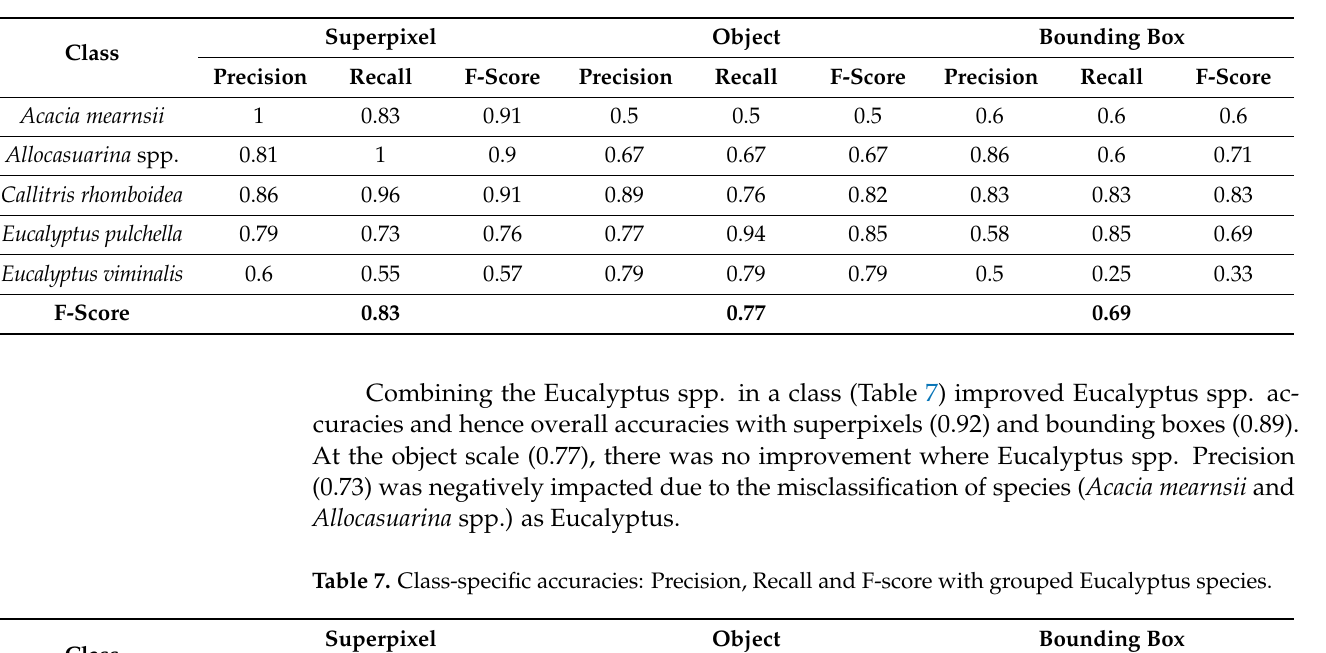
Table 6. Class-specific accuracies: Precision, Recall, and F-score at the three scales of analysis.